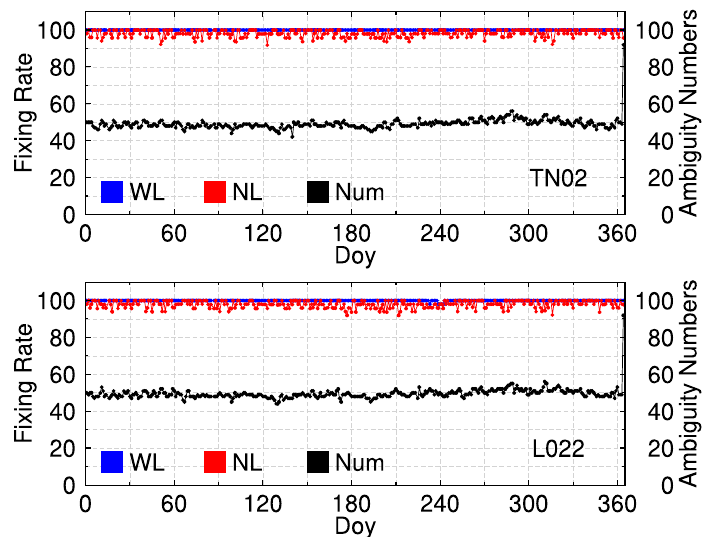
Figure 12. The ambiguity fixing rate of TN02 and L022 on each day for the whole year of 2013. We processed the GPS observations of TN02 and L022 with PPP method and DD method by forming a baseline L022-TN02. Since the baseline length is less than 600 m, the precision of DD baseline solutions can reach up to 1 mm in horizonal component and 1–2 mm in vertical component. To generate the corresponding baseline solutions for PPP, we simply differenced the PPP solutions of TN02 and L022 and transmitted the baseline time series into NEU (Figure